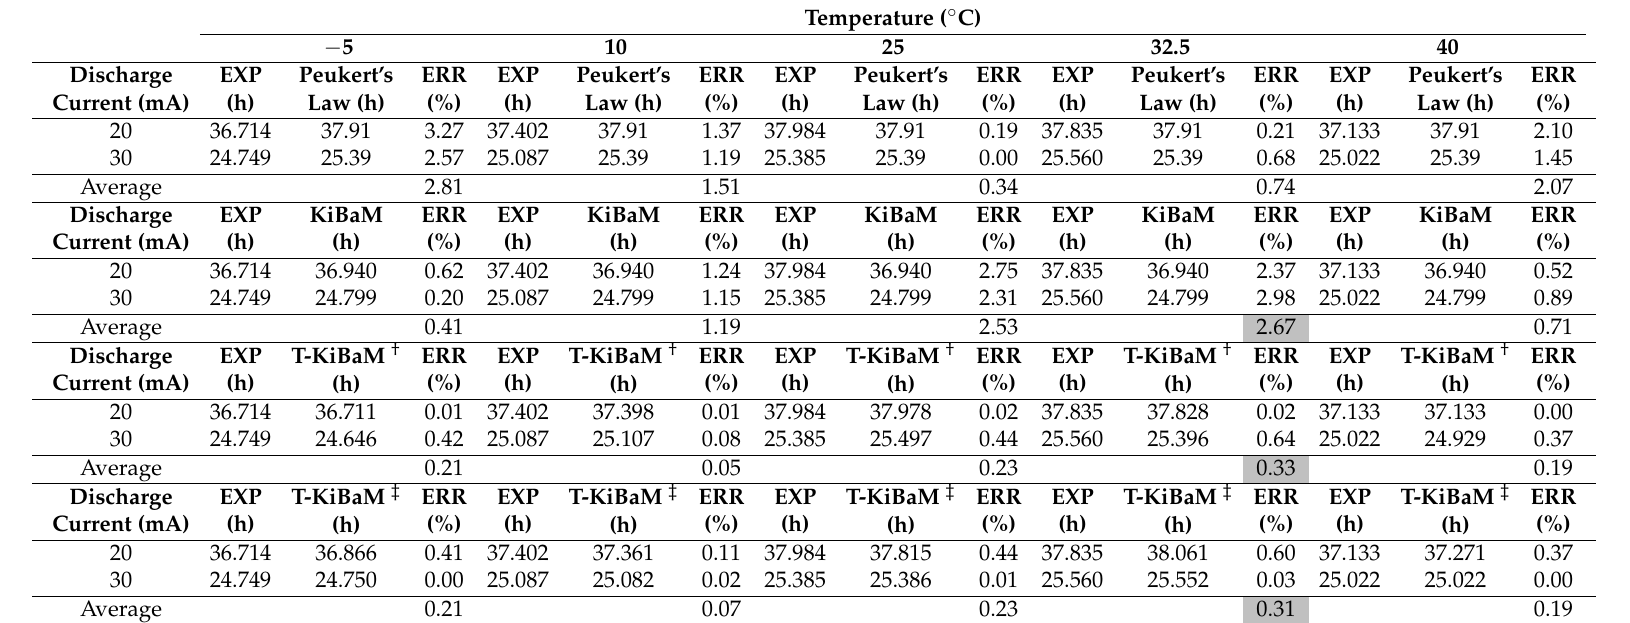
Table A1. Comparison between experimental and analytical